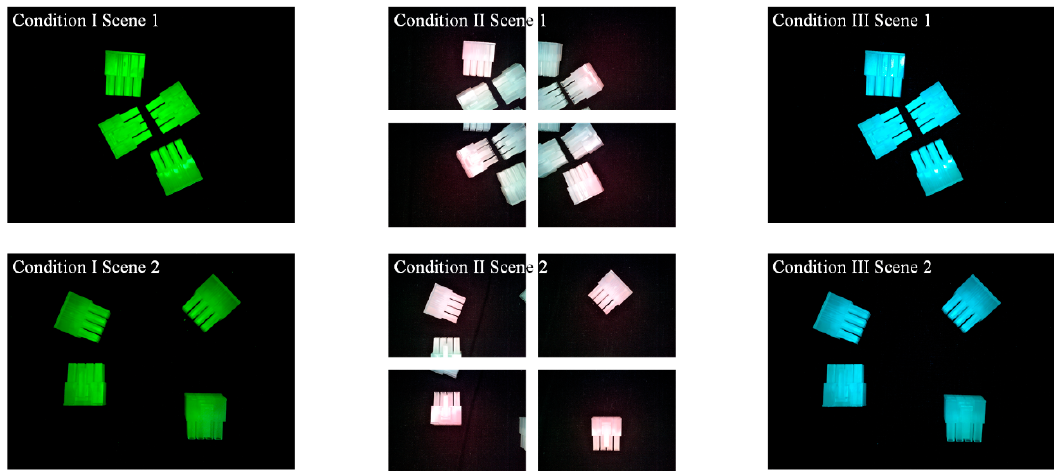
Figure 6. Optimal illumination and FOV conditions designed for the three conditions. Condition I: 1 shoot under strong green illumination. Condition II: four shoots under illumination with red component relatively higher. Condition III: 1 shoot under strong green and blue illumination. Table 3. Best-three designs of Condition I.